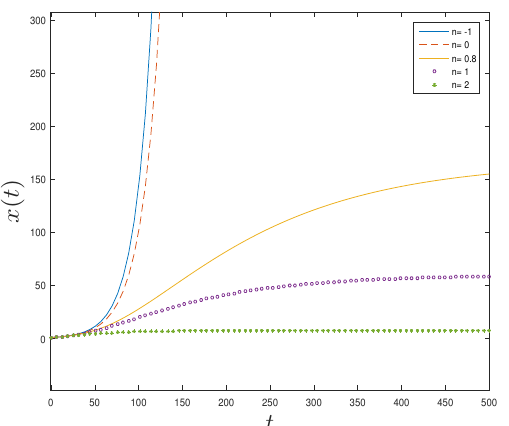
Figure 2. Simulation of dry mass growth as a function of time, where: n is the factor that allows for modification of the plant’s rapidity of growth in t time (days), and x ( t ) is the amount of dry matter (unit of mass). For parameter values n ∈ {− 1, 0, 0.8, 1, 2 } , σ = 0.07, g = 0.1 and m =